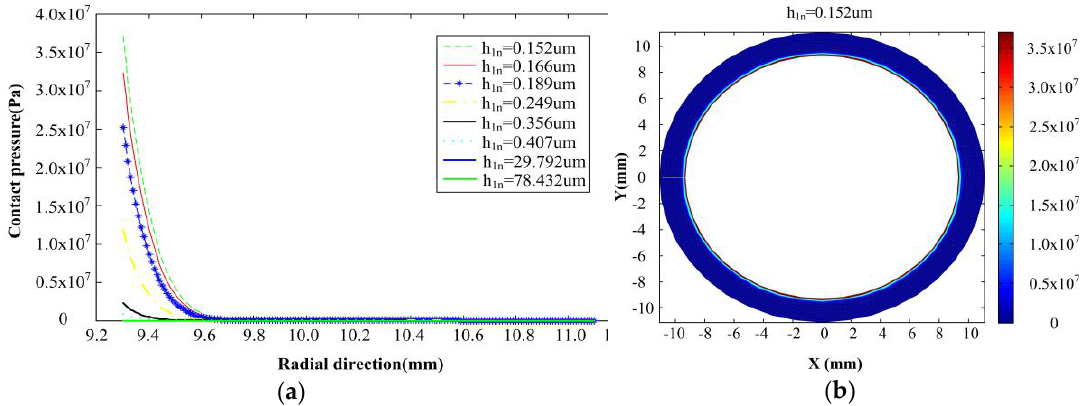
Figure 8. ( a ) The radial distribution of the contact pressure of the Gaussian surfaces p c ; ( b ) the contact pressure p c of the Gaussian surfaces in the seal ring.